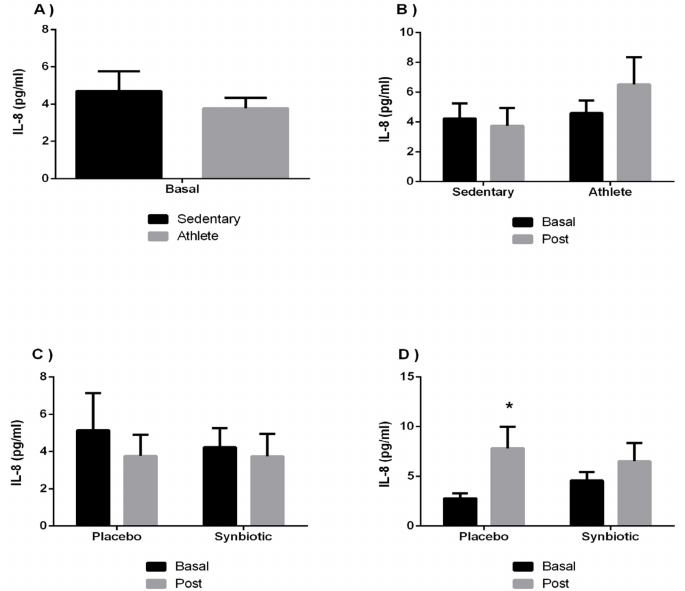
Figure 2. The effect of training and a synbiotic on the IL-8 cytokine. ( A ) Baseline serum IL-8 concentrations in sedentary men (n = 14) and athletes (n = 13). ( B ) Training effects on synbiotic effects on serum IL-8 concentration (n = 7 and n = 6 in sedentary and athlete groups, respectively). ( C ) Effect of synbiotic consumption on IL-8 in sedentary individuals with placebo (n = 7) or synbiotic (n = 7). ( D ) Effect of synbiotic consumption on IL-8 in athlete individuals with placebo (n = 6). The determinations are expressed by the mean ± SD of each of the samples. * p < 0.05 compared to